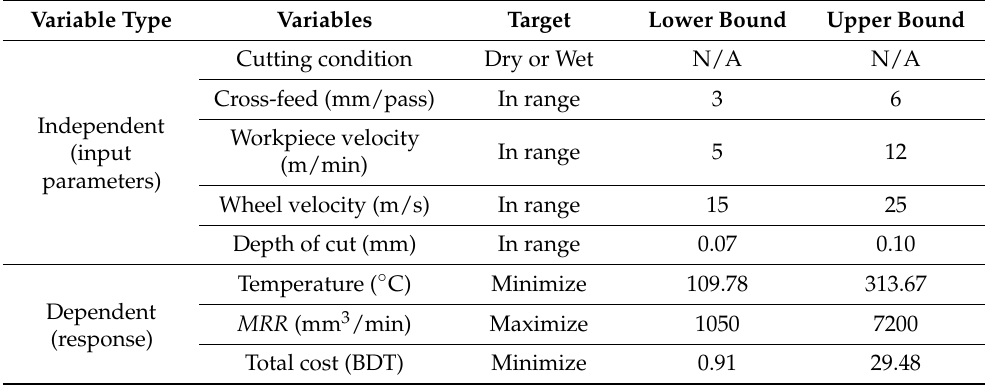
Table 6. Optimization criteria for input